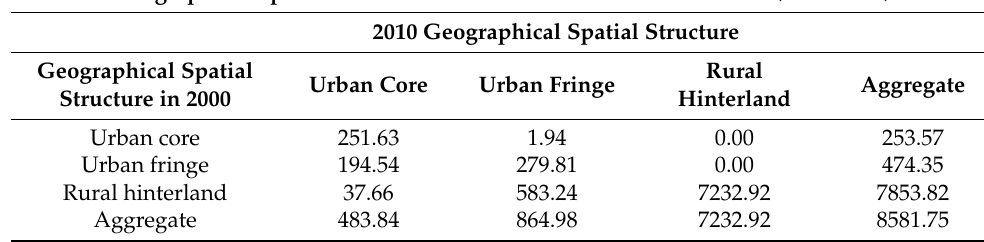
Table 5. Number of geospatial structure transfers in Wuhan, 2000–2010. Geographical Spatial Structure shift in Wuhan from 2000 to 2010 (Unit: km 2